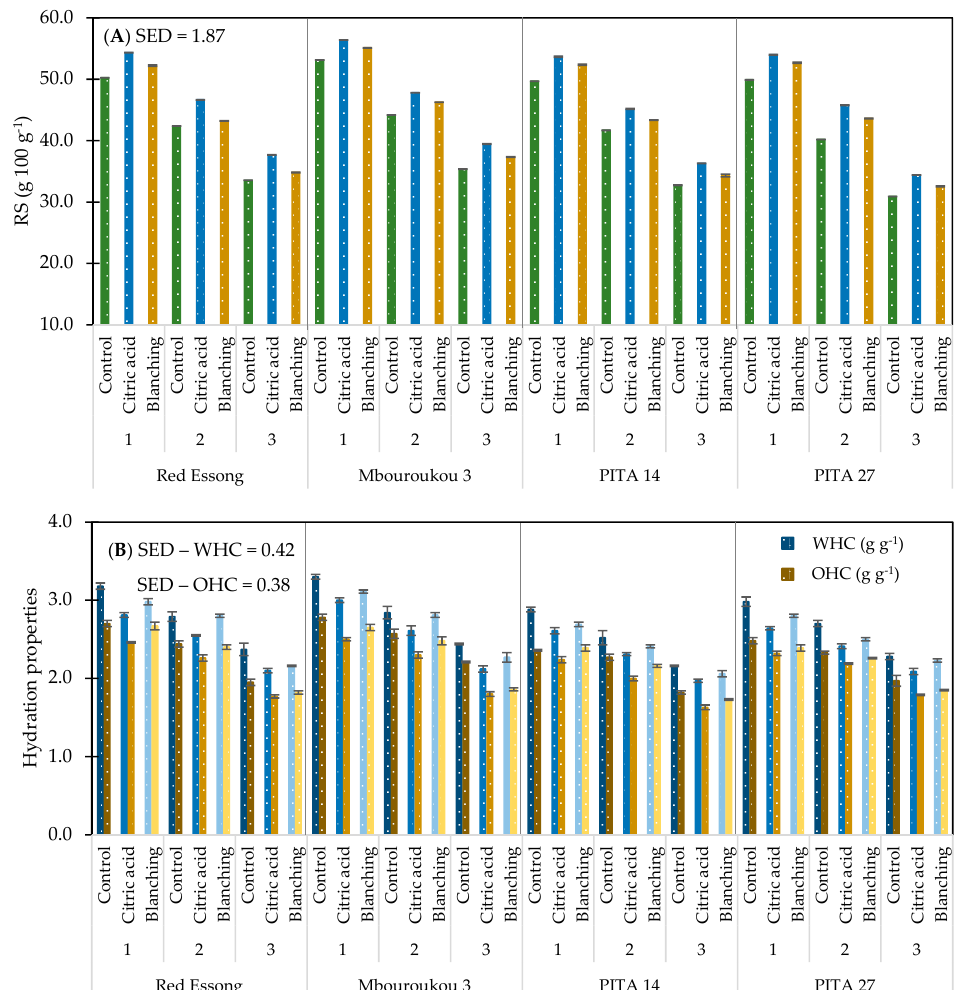
Figure 3. Resistant starch ( A ) and hydration properties ( B ) of plantain flours as influenced by cultivar, ripening stages, and pre-treatment methods. Ripening stage: 1 = mature green; 2 = green with a trace of yellow; and 3 = more green than yellow.